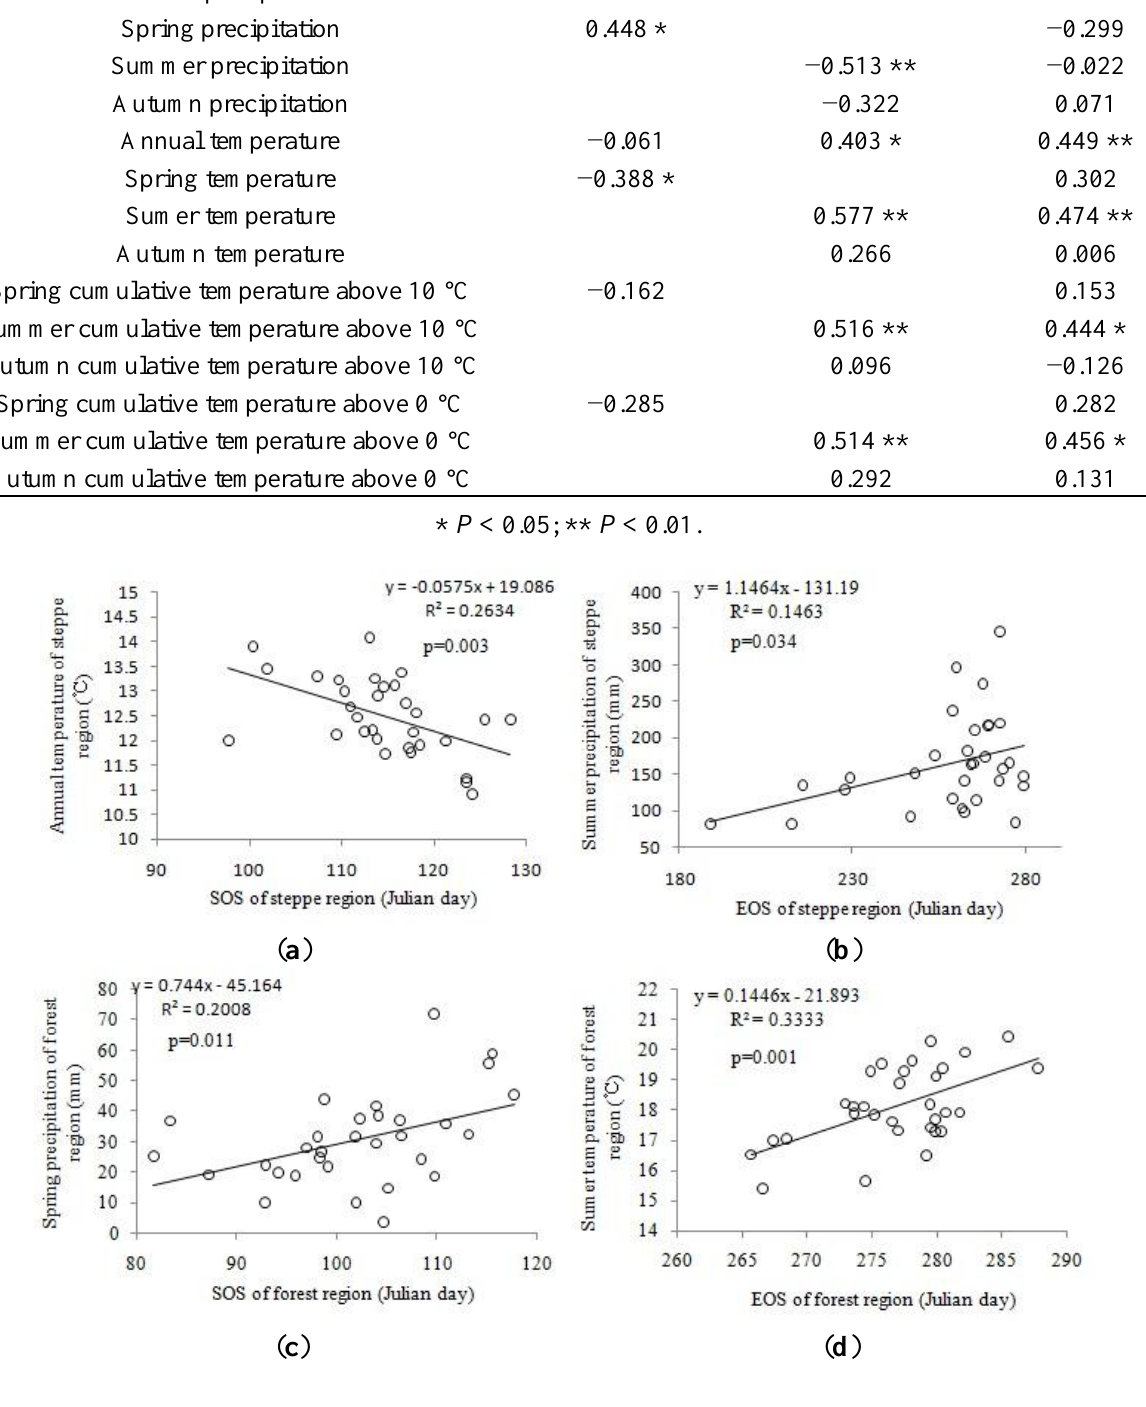
Figure 6. Relationships between phenological parameters and climatic variables for two regions of the study area. ( a ) SOS of the steppe region; ( b ) EOS of the steppe region; ( c ) SOS of the forest region; ( d ) EOS of the forest